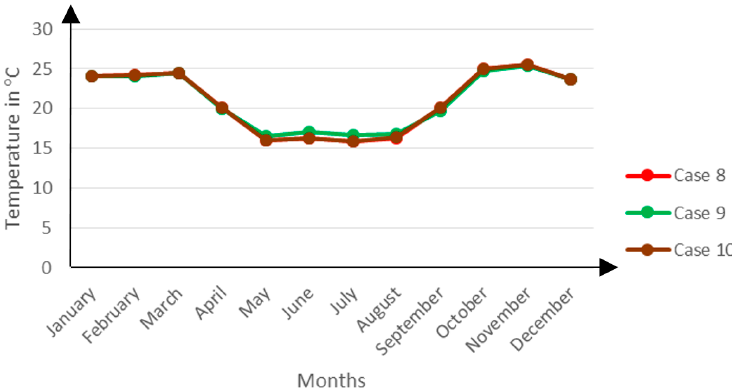
Figure 12. Monthly mean zonal temperatures for Cases 8, 9 and 10.